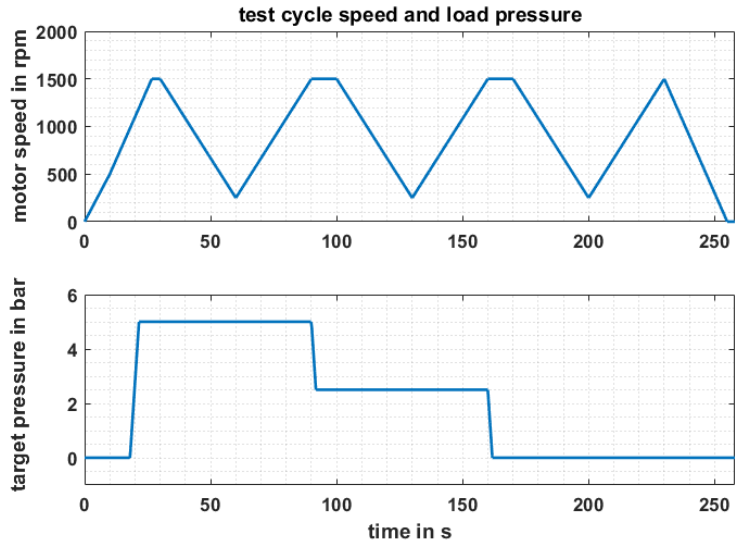
Figure 23. Test cycle: motor speed and pressure over time; One v-shaped ramp down and up for each load